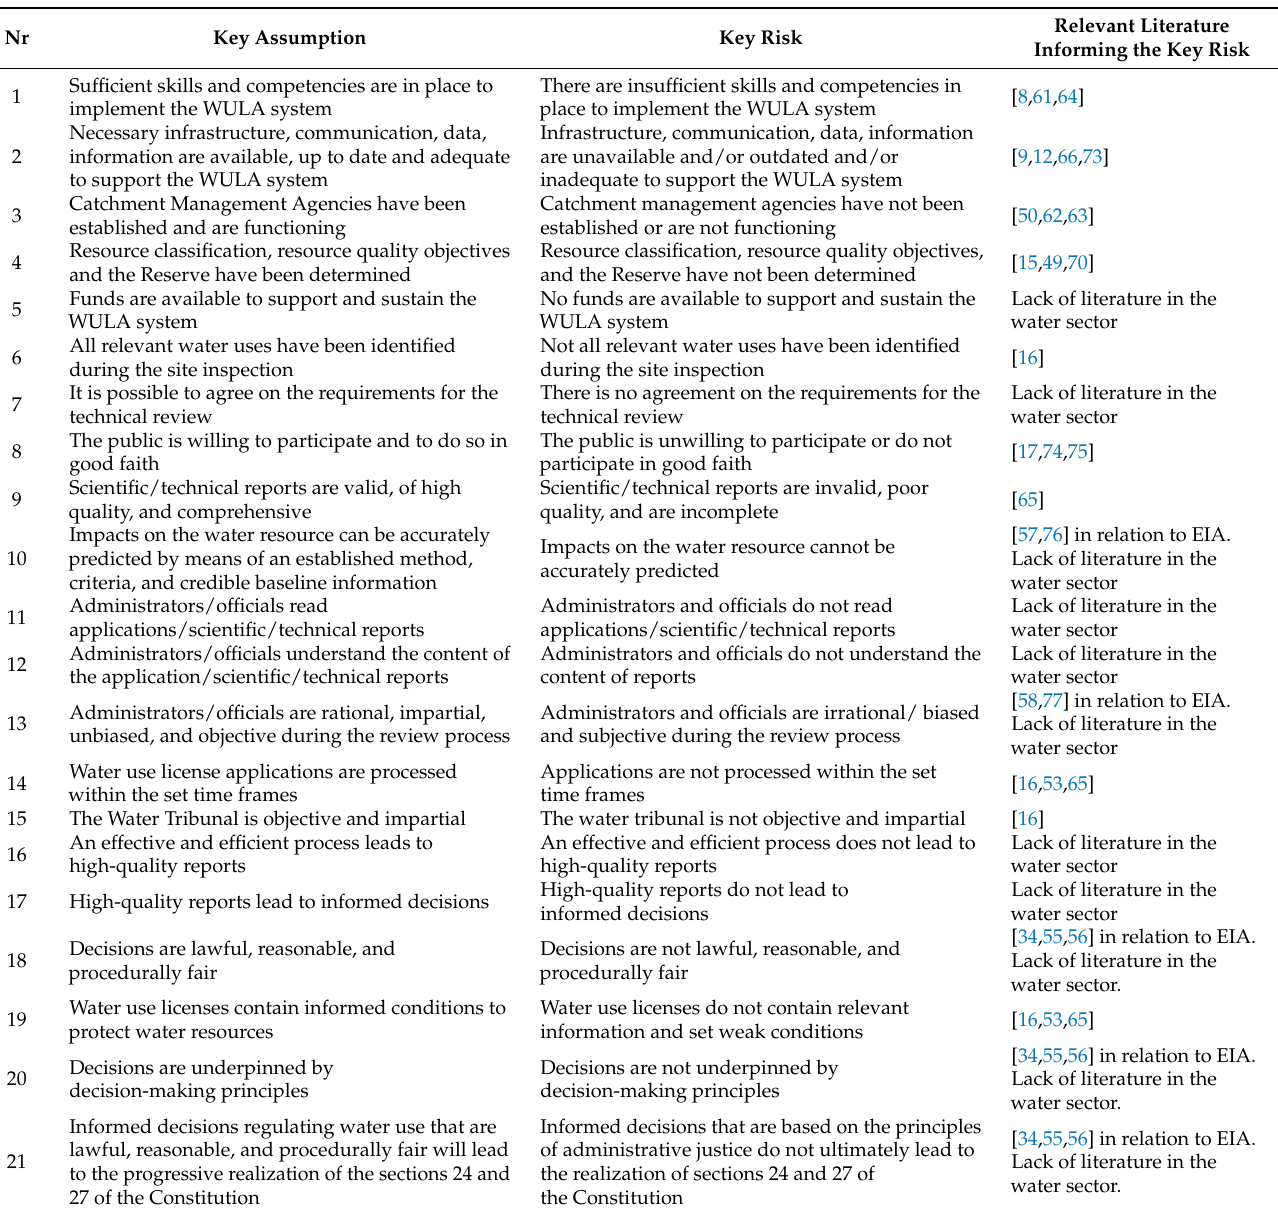
Table 1. Key assumptions and key risks for the South African WULA